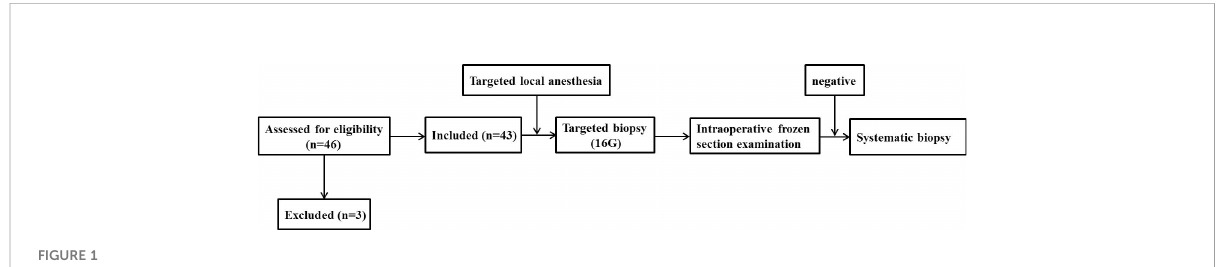
FIGURE 1 The fl ow diagram of the